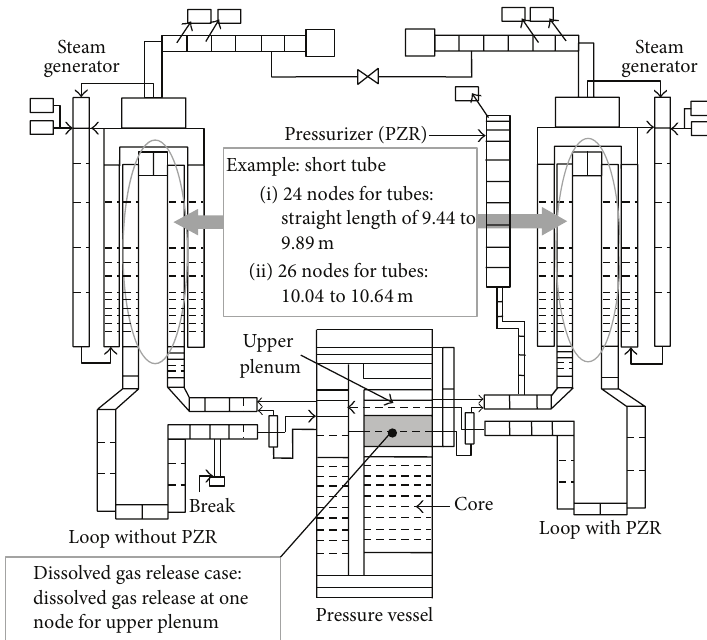
Figure 5: Noding schematic of LSTF for RELAP5